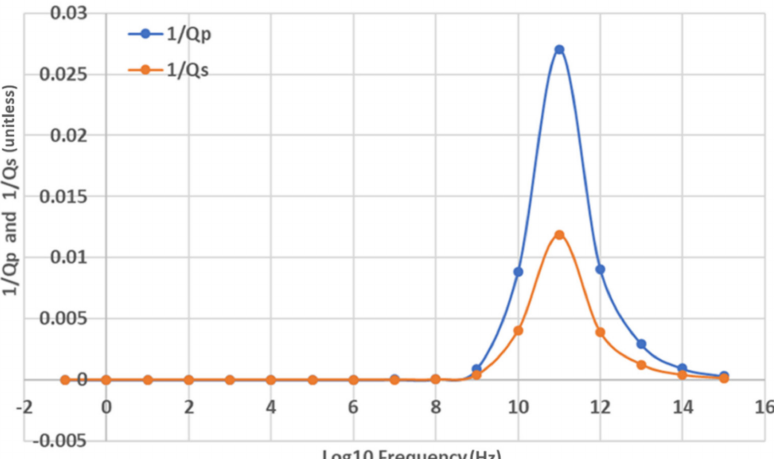
Figure 6. Cross plot of P-wave (blue) and S-wave (orange) attenuation based on Squirt-flow model versus log of frequency (Hz) for the Permian basin sample. Qp = P-wave quality factor, Qs = S-wave quality factor.